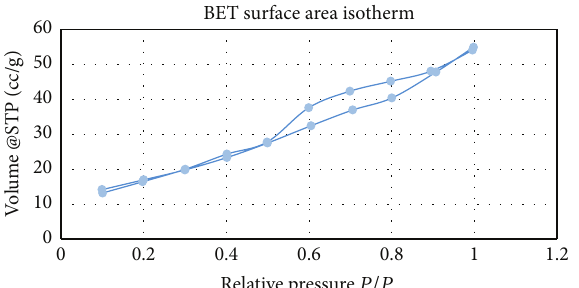
Figure 4: Isotherms of aluminium dross treated with 1% of NaOH at 30 minutes and temperature of 55 ∘